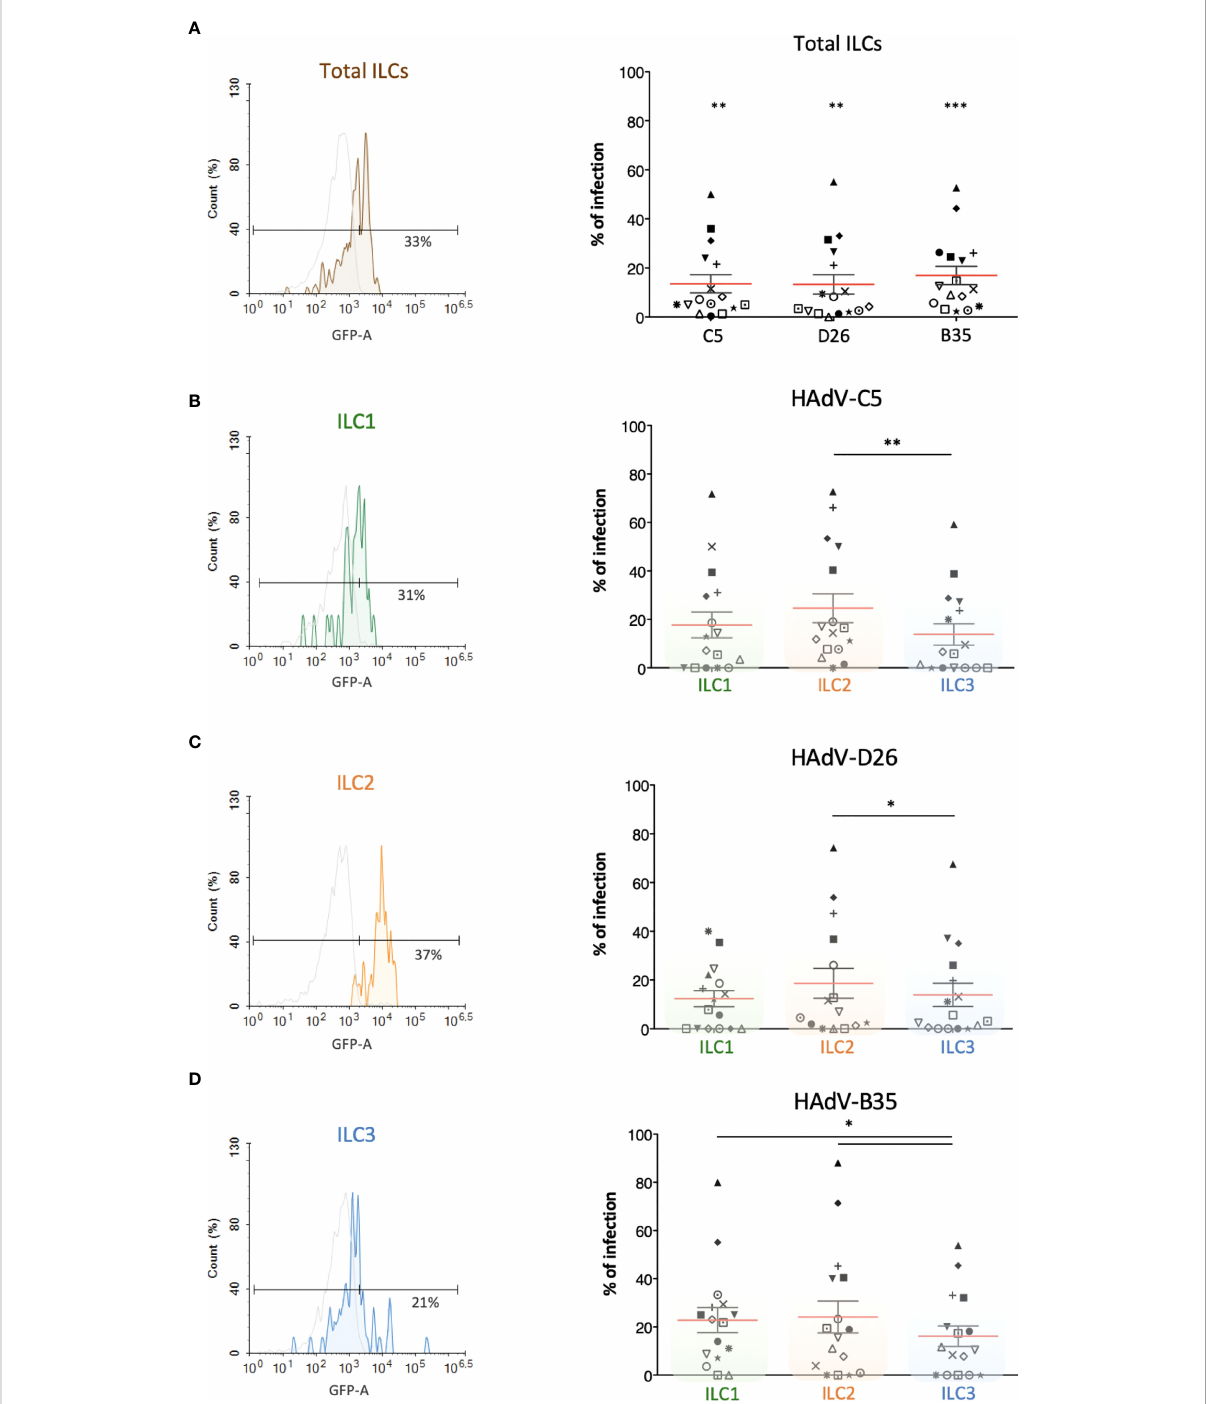
FIGURE 2 Evaluation of the capacity of ILCs to take up HAdV-C5, -D26 and -B35. HAdV vector-mediated GFP expression in total ILCs and in ILC subsets was quanti fi ed 24 h post-incubation (n = 16). The panels on the left (colour-coded to facilitate ILC subset identi fi cation) are representative data from a single donor, while panels on the right are cumulative data. (A) Result from one donor after HAdV-D26 uptake and mean percentages ± SEM of total ILCs expressing GFP after infection; (B – D) For each HAdV type, result from one donor after uptake by ILC1, ILC2, or ILC3 and mean percentages ± SEM of the ILC subsets expressing GFP after infection with (B) HAdV-C5, (C) HAdV-D26, or (D) HAdV-B35 (right panel). Statistical analyses were performed using paired Student ’ s t test by comparing uninfected cells and cells challenged with the HAdVs (ns, p > 0.05, * p ≤ 0.05, ** p ≤ 0.01, *** p ≤